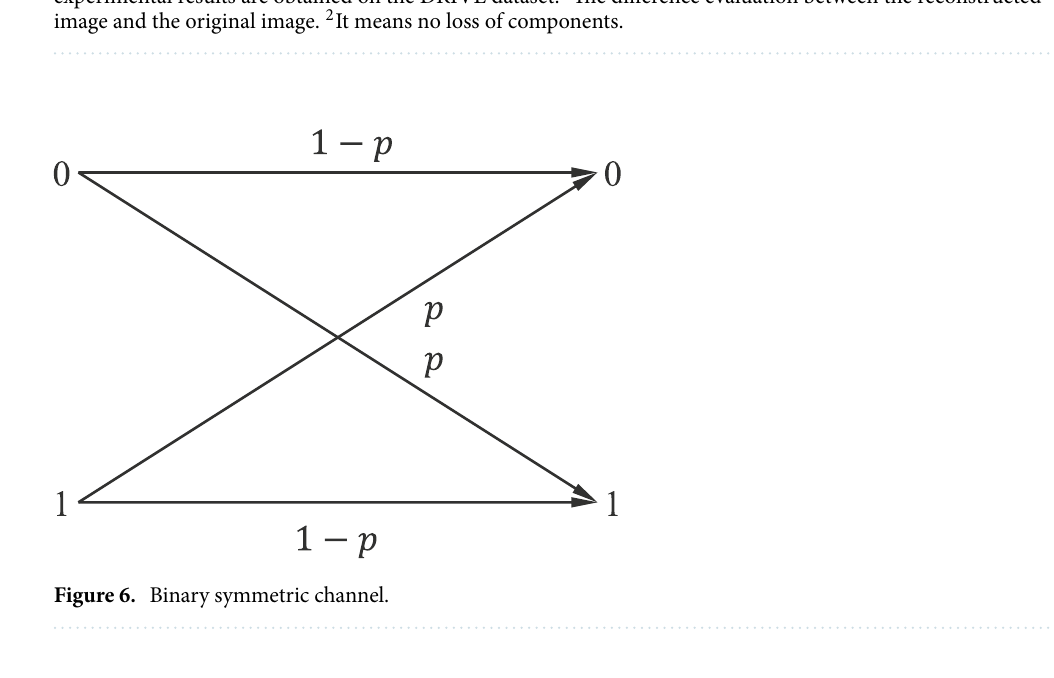
Image quality assessment